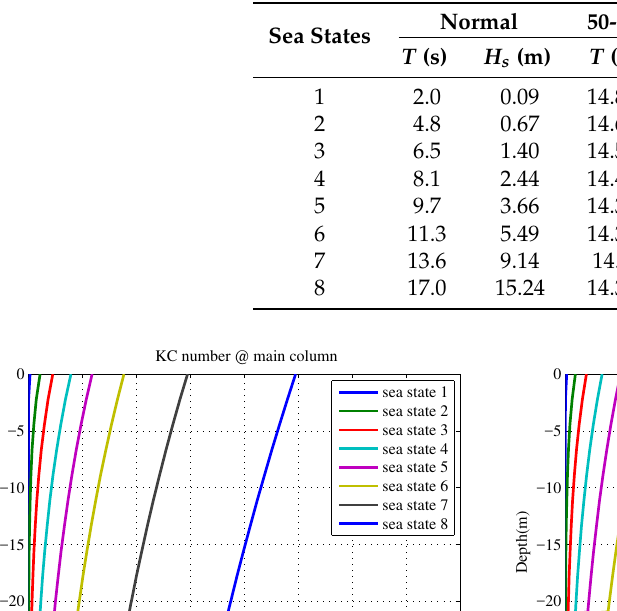
Table 9. Sea states defined by wave spectral peak period, T , and significant wave height, H s , selected for the dynamic analyses.